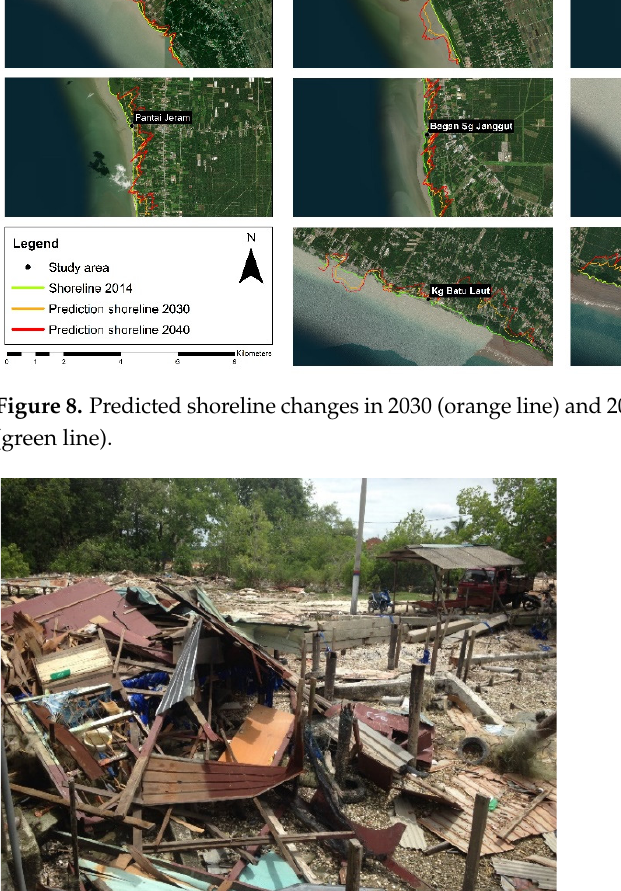
Figure 10. Facilities damage impacts on shoreline changes in Pantai Kelanang. The shoreline change statistics (SCE, NSM, and EPR) reported for the case study were able to demonstrate the large-scale patterns of retreat and expansion of the shorelines in the research study. Different statistical methods were similarly successful at revealing the spatial and temporal movement patterns [28]. SCE was chosen due to its ability to provide the variation envelope and because it is the sole metric that takes into consideration all shorelines. The NSM and EPR only show the difference between the initial and most re- cent measurements. The selection of DSAS statistical parameters in the case study enabled the investigation of the temporal and spatial dynamics of the coastal change and the geo- morphic variability along the coastline due to their capacity to utilise all coastline posi- tions (SCE), the cumulative shoreline movement (NSM), and the time variations (EPR) that encompass the rate range of the set of data [29]. The SCE measures the total change in coastline, considering all available coastline positions, and reports on their distance without reference to a specific date, and the NSM measures the distance of coastline change between the longest coastline and the newest coastline, while the EPR calculates the speed of shoreline change by dividing the distance between the longest coastline and the most recent coastline by time. EPR is suggested to be the most applicable in this study for measuring the speed of shoreline changes [30]. This is supported by a previous study, which described that the advantage of this algorithm is that it requires only two shoreline dates for its computation; its disadvantage appears when there are many shorelines, as all intermediate shorelines dates are ignored [31].